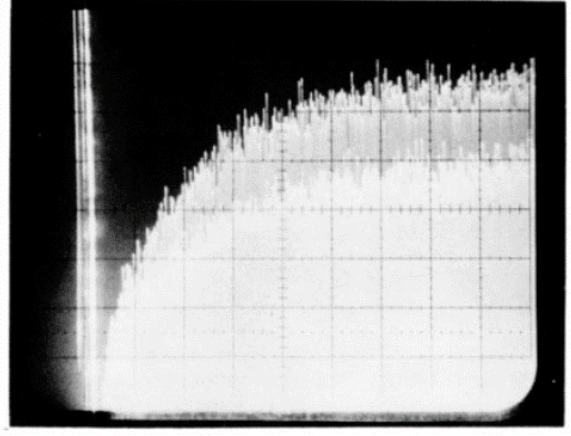
Figure 15. Oscilloscope trace of the proton recovery of water. (reproduced with permission from [41]. Copyright IOP, 1982).